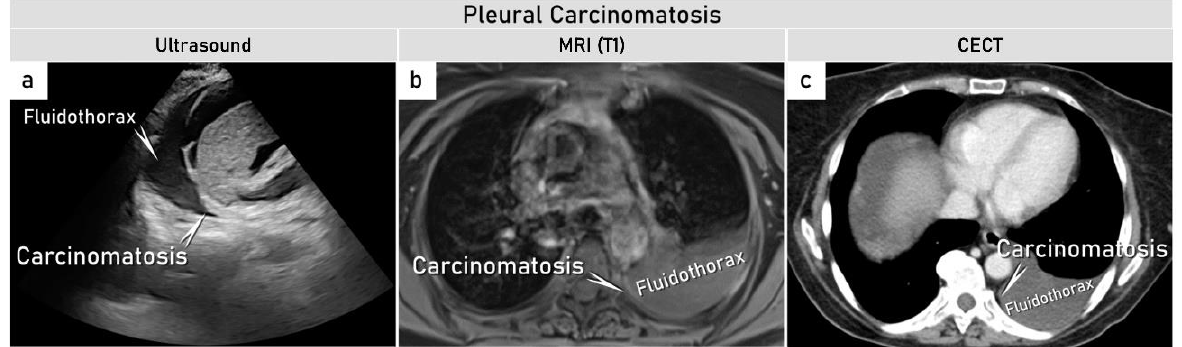
Figure 5. Demonstration of a patient with ovarian cancer (FIGO stage IVB) with pleural parietal carcinomatosis. Sagittal ultrasound images showing left parietal pleural carcinomatosis and hydrothorax ( a ), with corresponding axial WB-MRI (CE-T1WI-FS) ( b ) and CECT ( c ). CECT, contrast enhanced computed tomography; CE-T1WI-FS, contrast-enhanced T1-weighted imaging with fat suppression; FIGO, International Federation of Gynecology and Obstetrics; WB-MRI, whole-body magnetic resonance